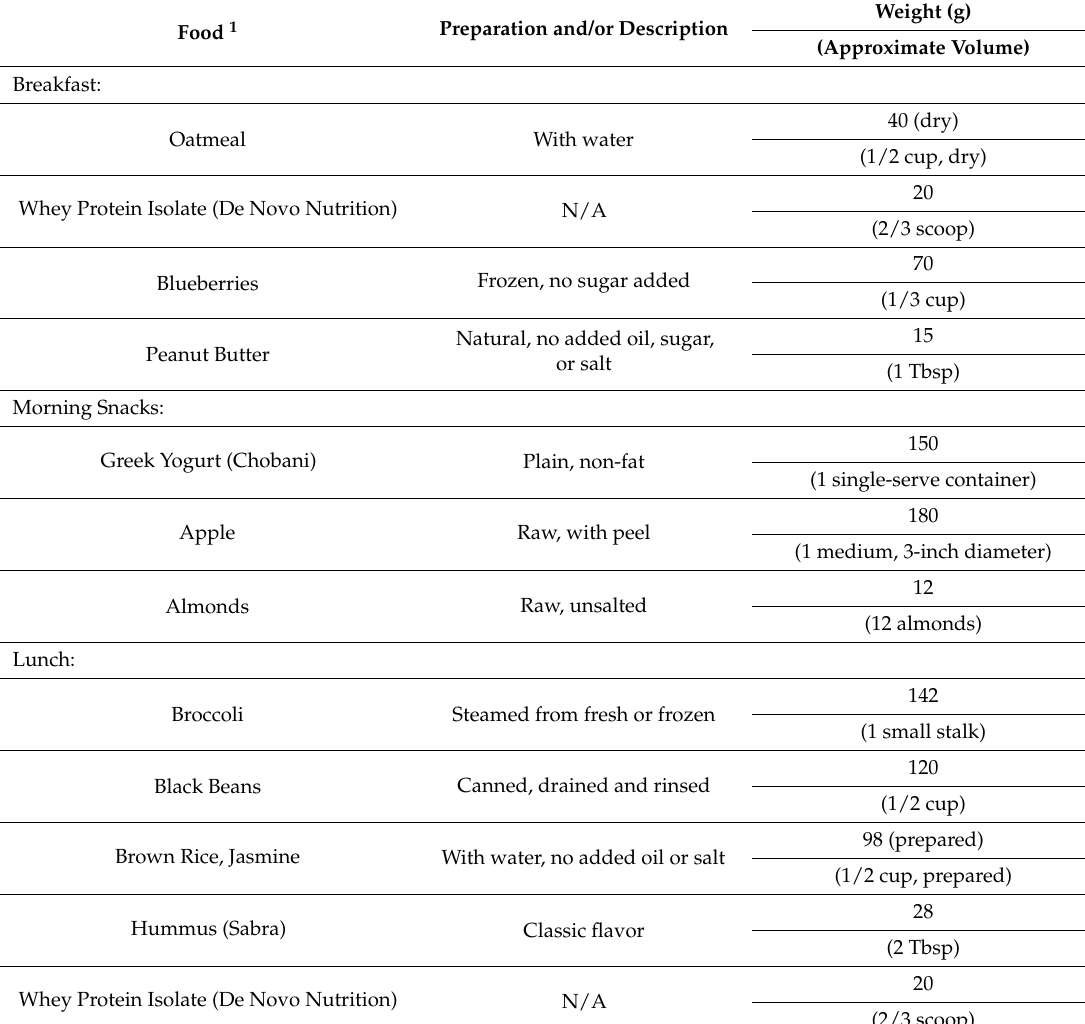
Table 1. Sample Weighed Food Record Representative of a Typical Day During both PREP and